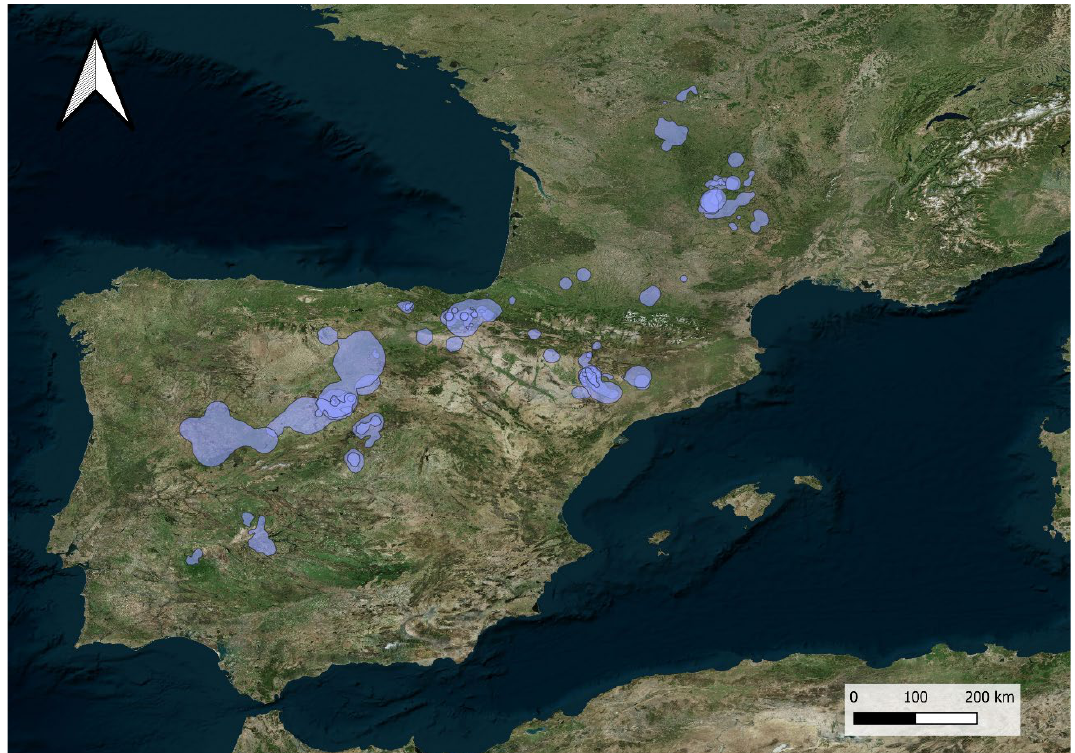
Figure 1. Wintering areas (95% KDE) used by the 44 tagged red kites during their non-breeding seasons in Spain and Southern France. Table 1. Home range size (km 2 ) and duration of 72 wintering seasons of 44 red kites tracked by GPS satellite telemetry in Spain according to their number of wintering areas, sex, and age (adults or immatures). Results are expressed as mean and standard deviation. Minimum and maximum values appear in parenthesis. Red kites with two wintering areas were excluded from the age (adults, immatures) and sex (males, females) pools. MCP—minimum convex polygon. * Only considering complete winter, not partial.